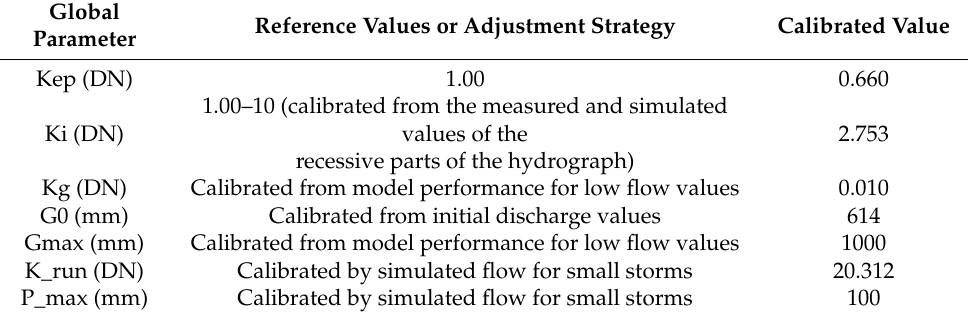
Table 4. Calibrated global